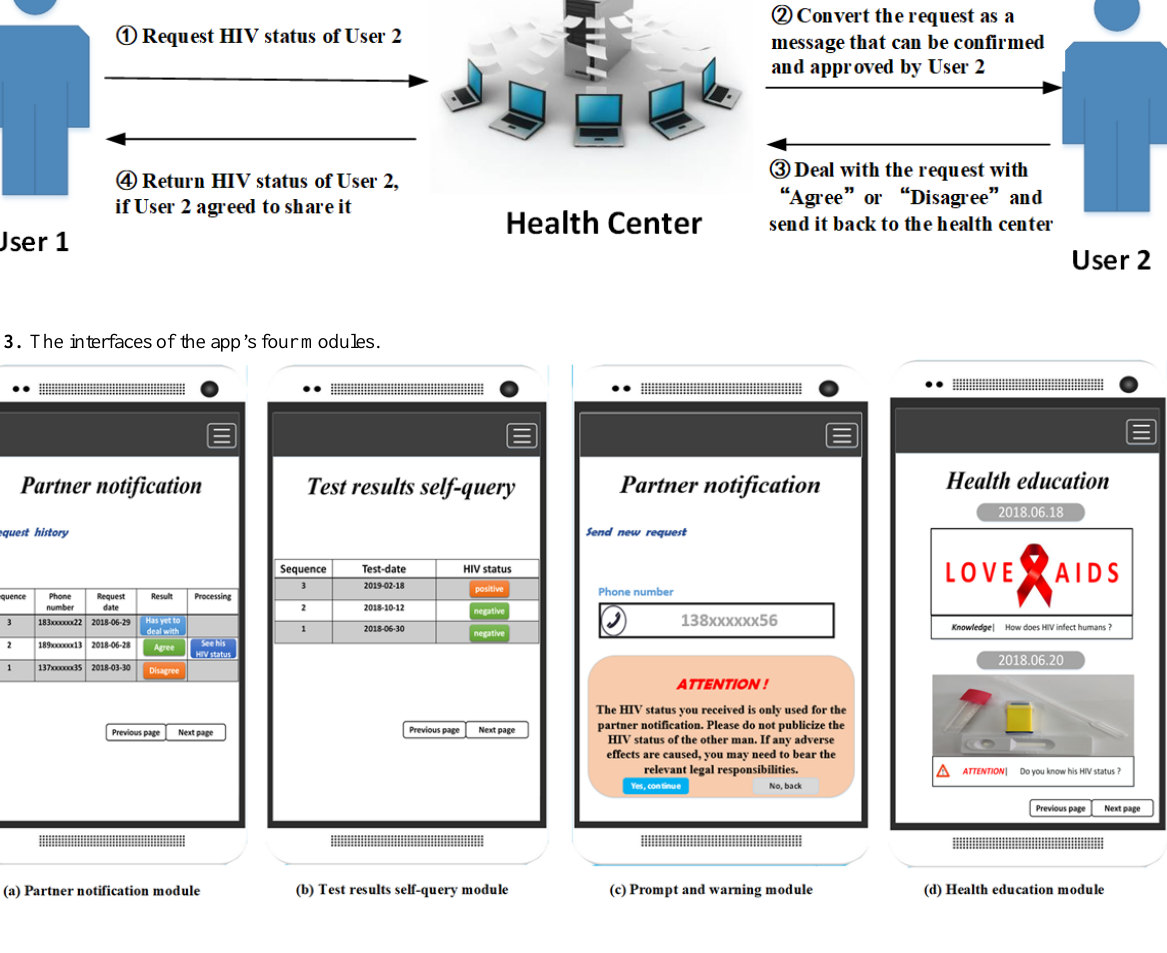
Figure 2. The framework of the partner notification system.